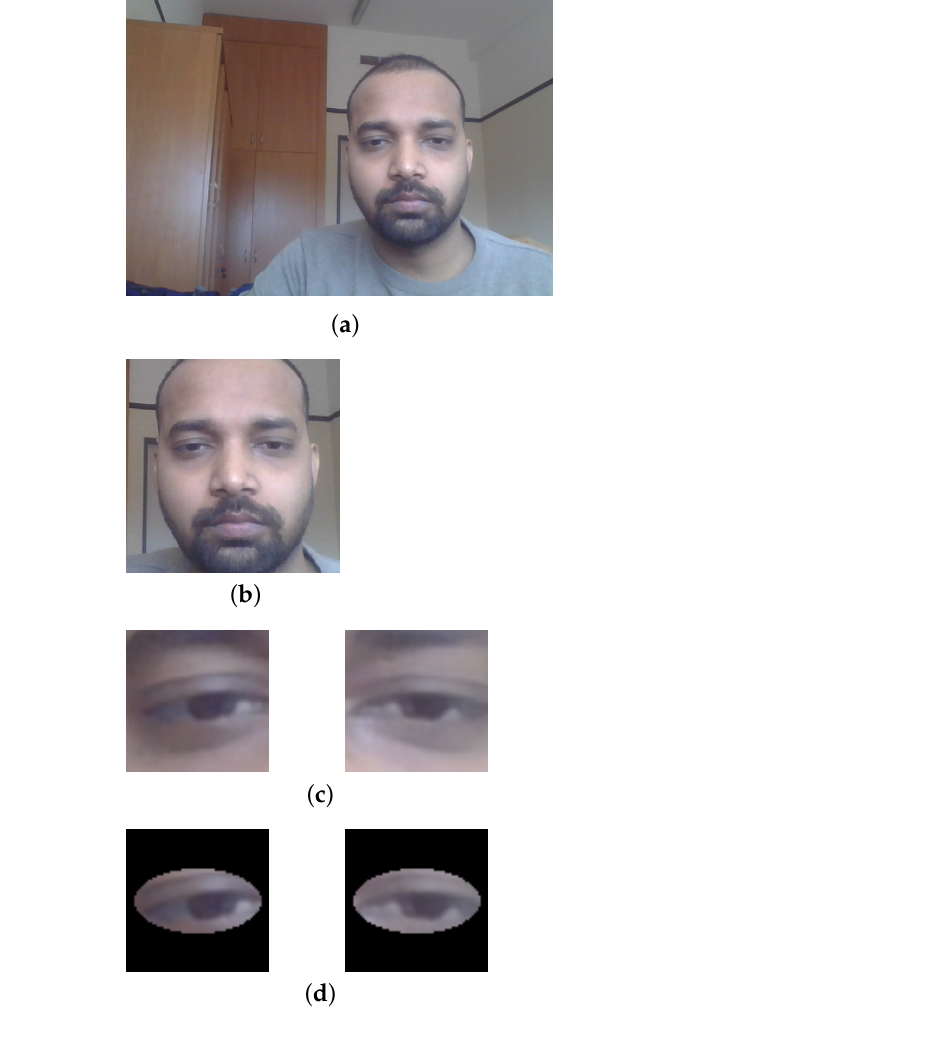
Figure 2. Pre-processing steps. ( a ) Step 1: Original image. ( b ) Step 2: Face detection. ( c ) Step 3: Eye detection. ( d ) Step 4: Eye